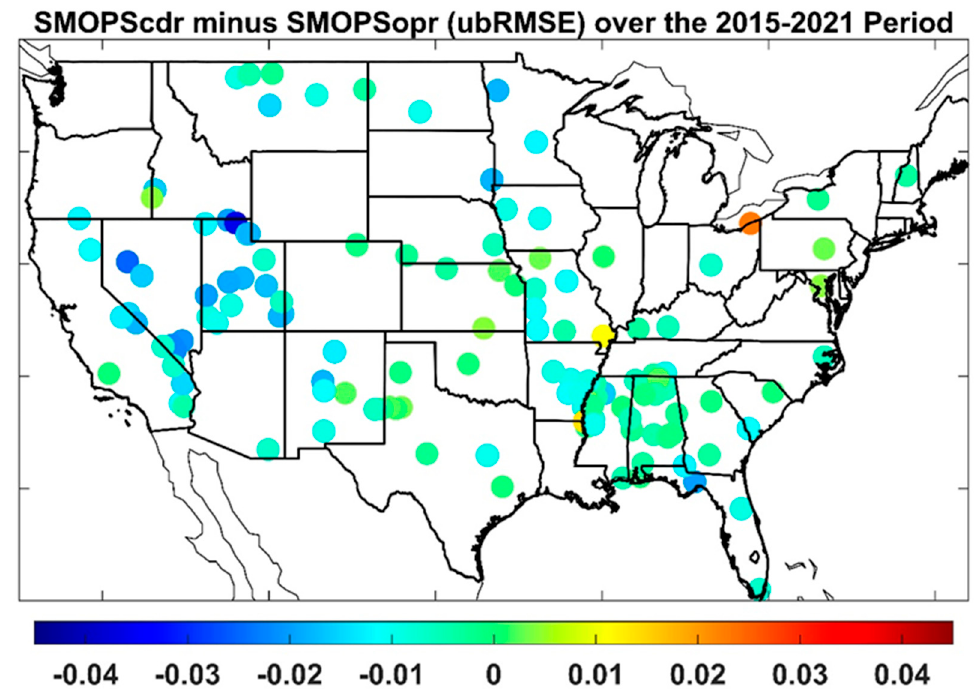
Figure 5. Differences in SCAN observations-based ubRMSE between the developed SMOPScdr and the current operational SMOPS (SMOPSopr) data products during the 1 April 2015–30 August 2021 time period.